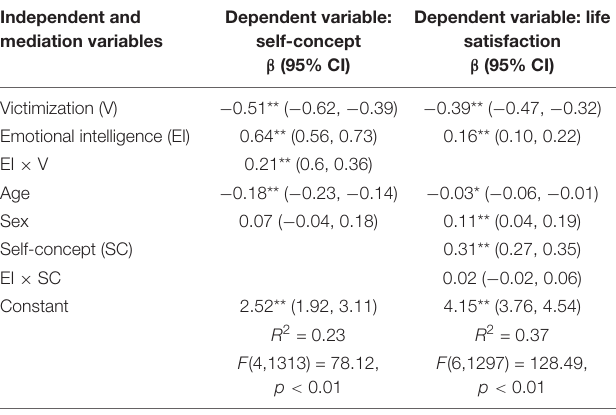
TABLE 3 | Coefficients for the tested moderated mediation model linking victimization, self-concept, life satisfaction, and emotional